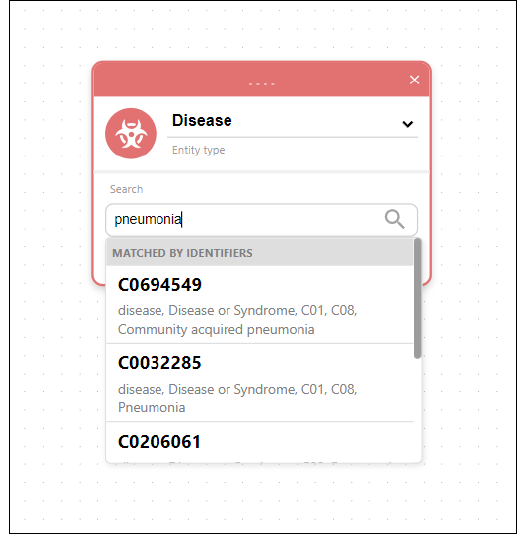
Figure 9. Searching diseases using keyword